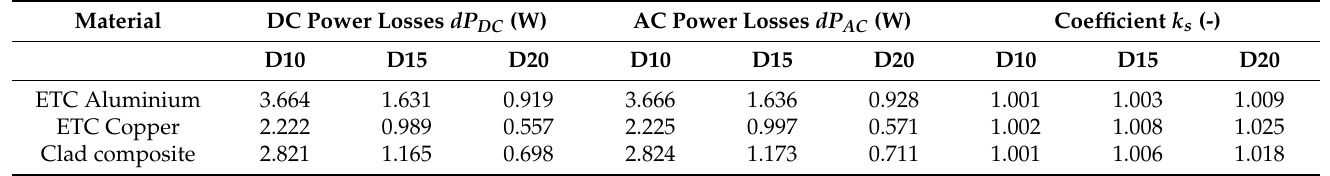
Table 2. Power losses during alternating current (AC) and direct current (DC)